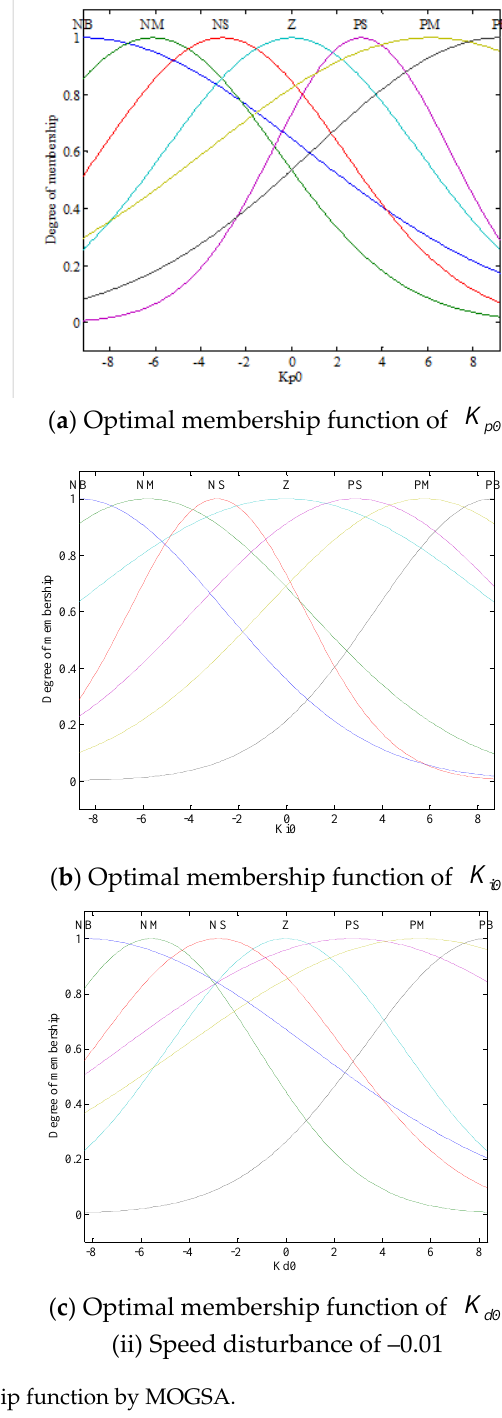
Figure 11. Comparison of speed curves by different controllers. Table 6. Optimal parameters of controllers for pumped storage unit regulating system under rotational speed disturbance. Speed Disturbance